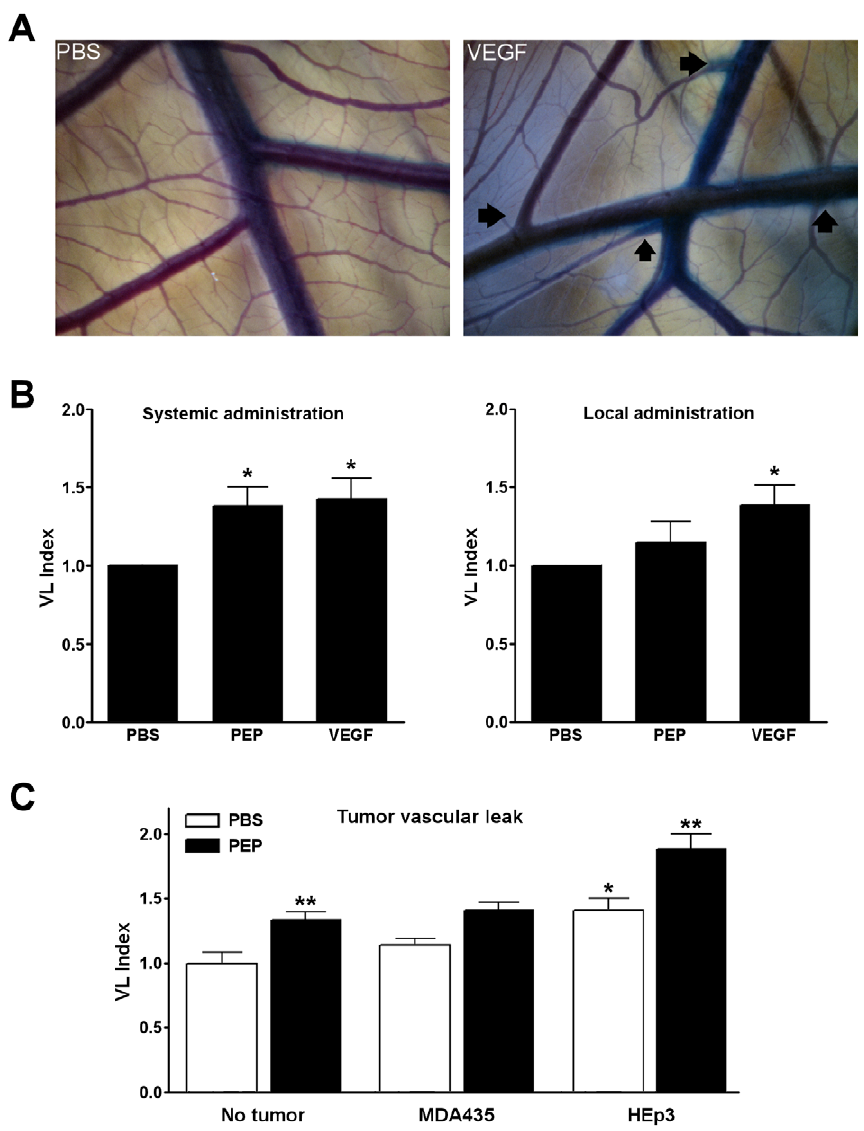
Figure 1. The Miles assay measures vascular permeability changes in the CAM. A. Bright field images of CAM vasculature following injection of Evan’s blue dye subsequent to the systemic administration of PBS (left panel) or VEGF (right panel). Arrows indicate areas of visible vascular leak. B. When VEGF or PEP is injected intravenously distal to the site of analysis, a significant level of vascular permeability is observed in the CAM (left). Topically administered VEGF but not PEP induces a significant level of vascular permeability (right). C. Vascular permeability changes in the CAM were evaluated in the presence of human tumor xenografts. Increased vascular permeability was observed at the tumor site, particularly in HEp3 tumors. Systemically administered PEP (0.1 nM) further increases vascular permeability. Data are presented as Mean + / 2 SEM, n . 15 for each group. * indicates statistical significance, p , 0.05, ** p , 0.01.